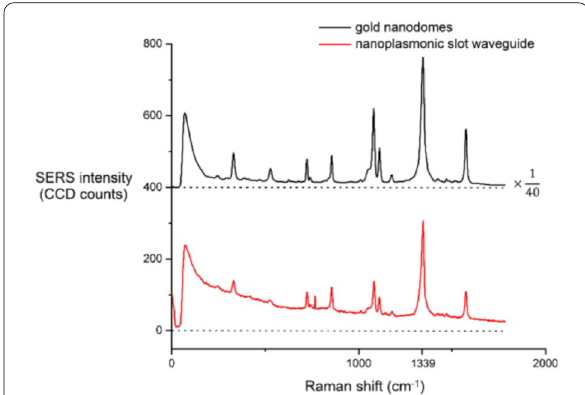
Fig. 14 Averaged SERS spectra of the NTP monolayer acquired on gold nanodomes and on the nanoplasmonic slot waveguide. The spectrum on the gold nanodomes was obtained using a laser power of 300 µW and an integration time of 0.13 s. The spectrum on the nanoplasmonic slot waveguide was obtained using a laser power of 350 µW and an integration time of 10 s. The SERS spectrum on the nanodomes was divided by a factor of 40 to allow for better visualization. We subtracted the dark counts, but not the SERS background of the spectra. The spectra are offset on the y-axis for clarity, and the dashed line represents the zero line of each spectrum. Reprinted with permission from Refs. [64]